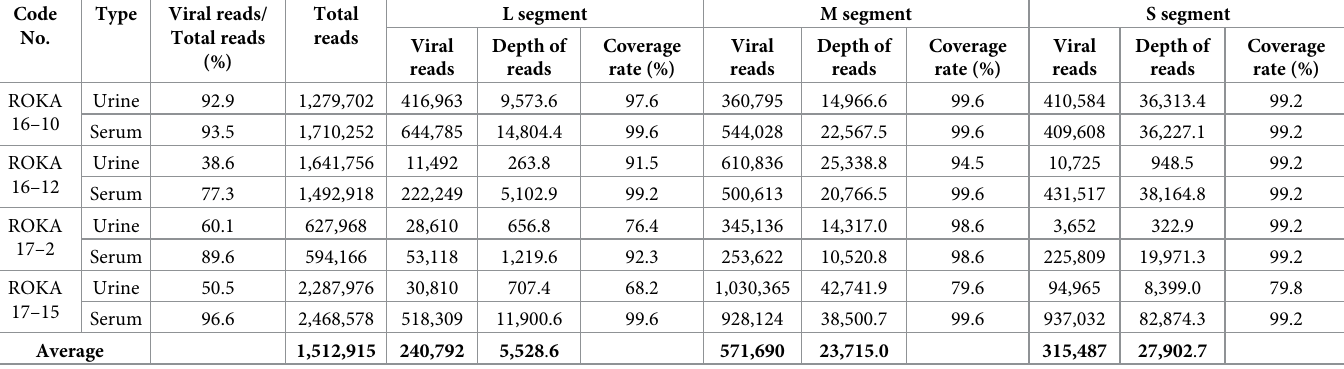
Table 4. Summary of total reads and read mapping to Hantaan virus (HTNV) reference genome by HTNV multiplex polymerase chain reaction-based next genera- tion sequencing. Code